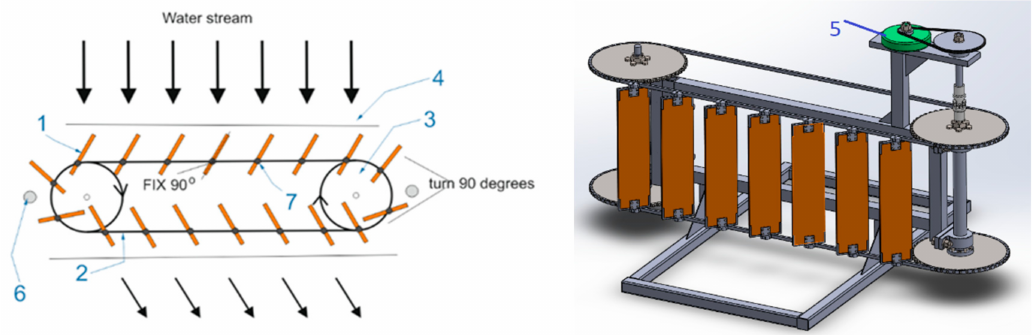
Figure 2. General view of Lenyov hydrobelt: 1—plate; 2—drive belt-chain; 3—«asterisks»; 4—housing construction; 5—electric generator.